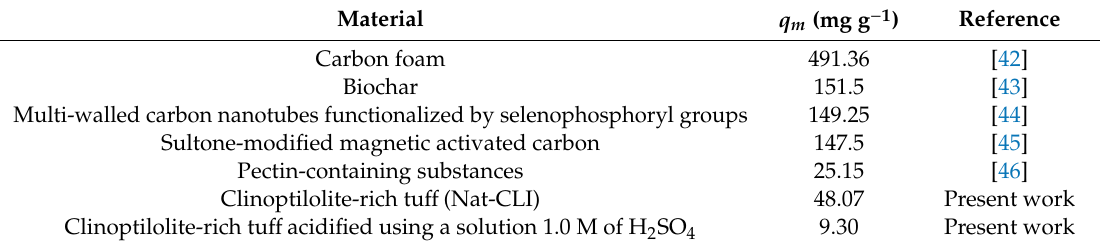
Table 4. Maximum sorption capacity of Pb(II) by materials with di ff erent nature.